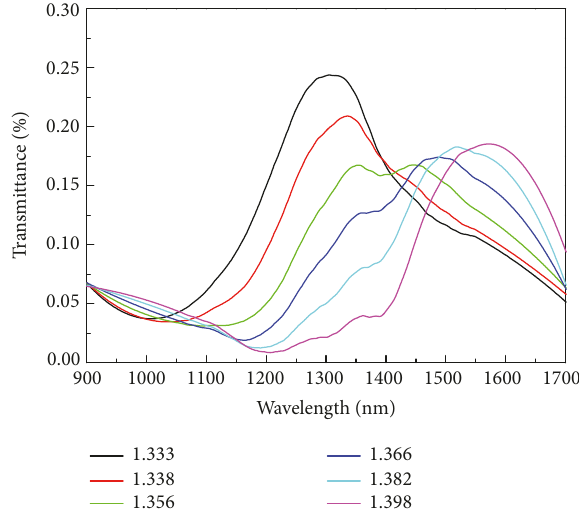
Figure 4: LMR spectra of the D-shaped fibers coated with TiO 2 nanofilm for different liquid refractive indices.